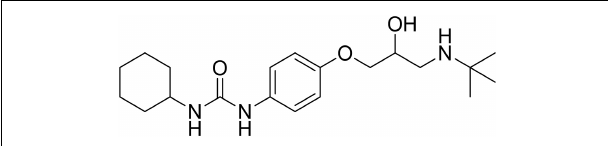
FIGURE 1 | Chemical structure of talinolol (TAL, M.W: 363.5, pKa: